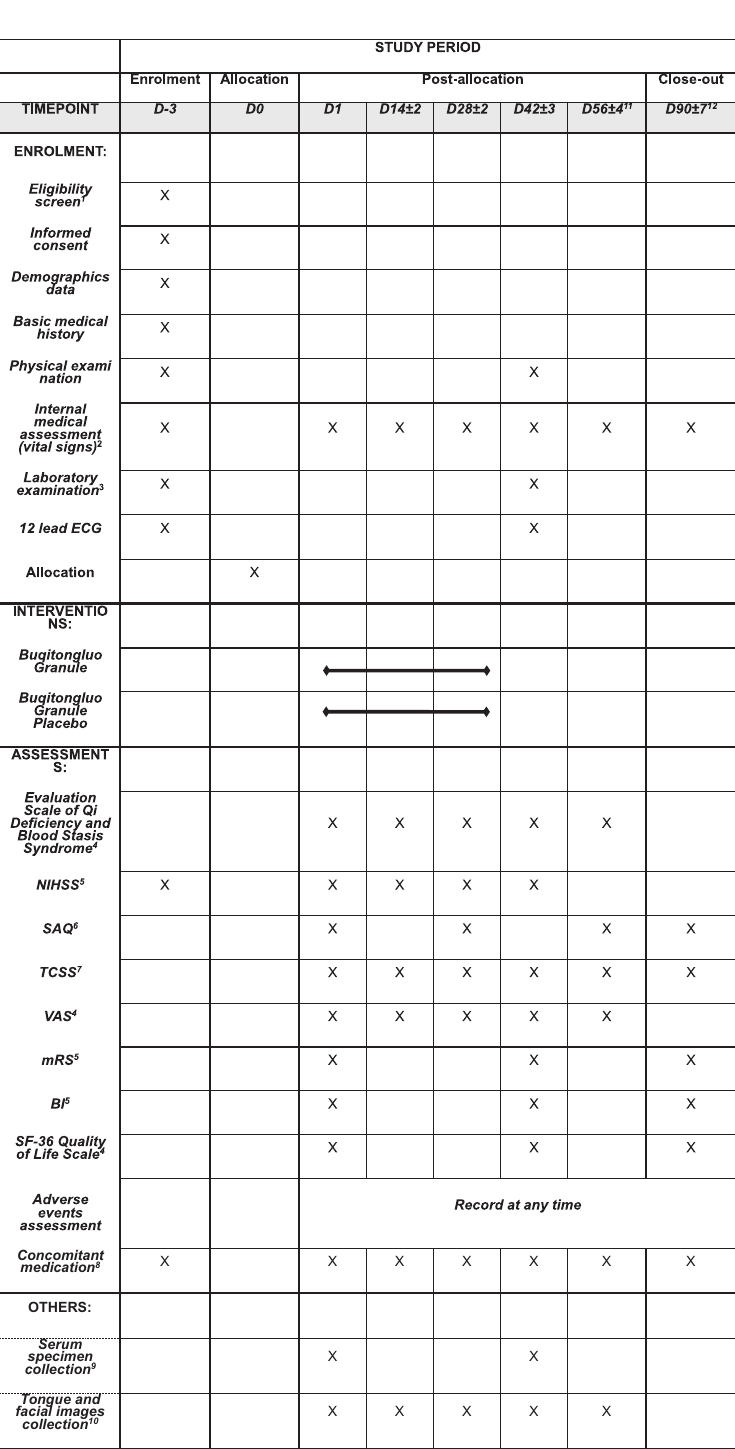
TABLE 1 | The schedule of enrolment, interventions, and assessments in the BOSS